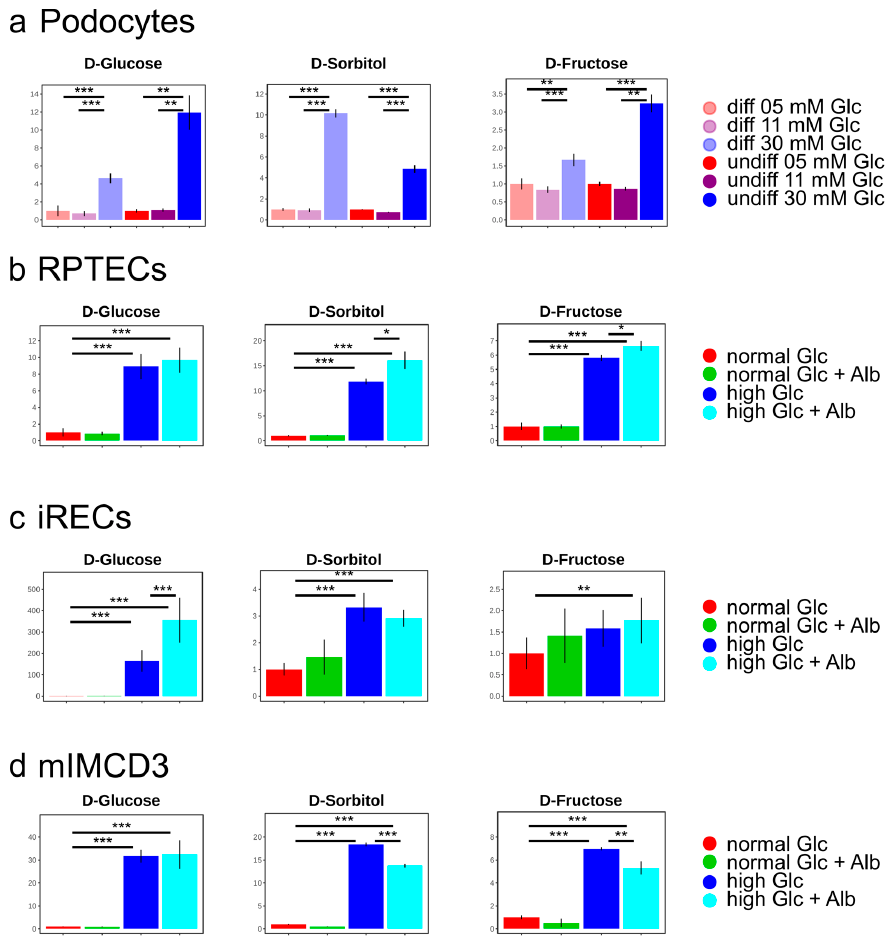
Figure 3. Bar charts of the polyol pathway metabolites for the podocyte cell lines ( a ), for the proximal tubular cell lines RPTECs ( b ), and iRECs ( c ), as well as for the collecting duct cell line mIMCD-3 ( d ). Fold changes to the normal glucose condition. Error bars indicate standard deviation. * p < 0.05; ** p < 0.01; *** p < 0.001; n = 4–8.